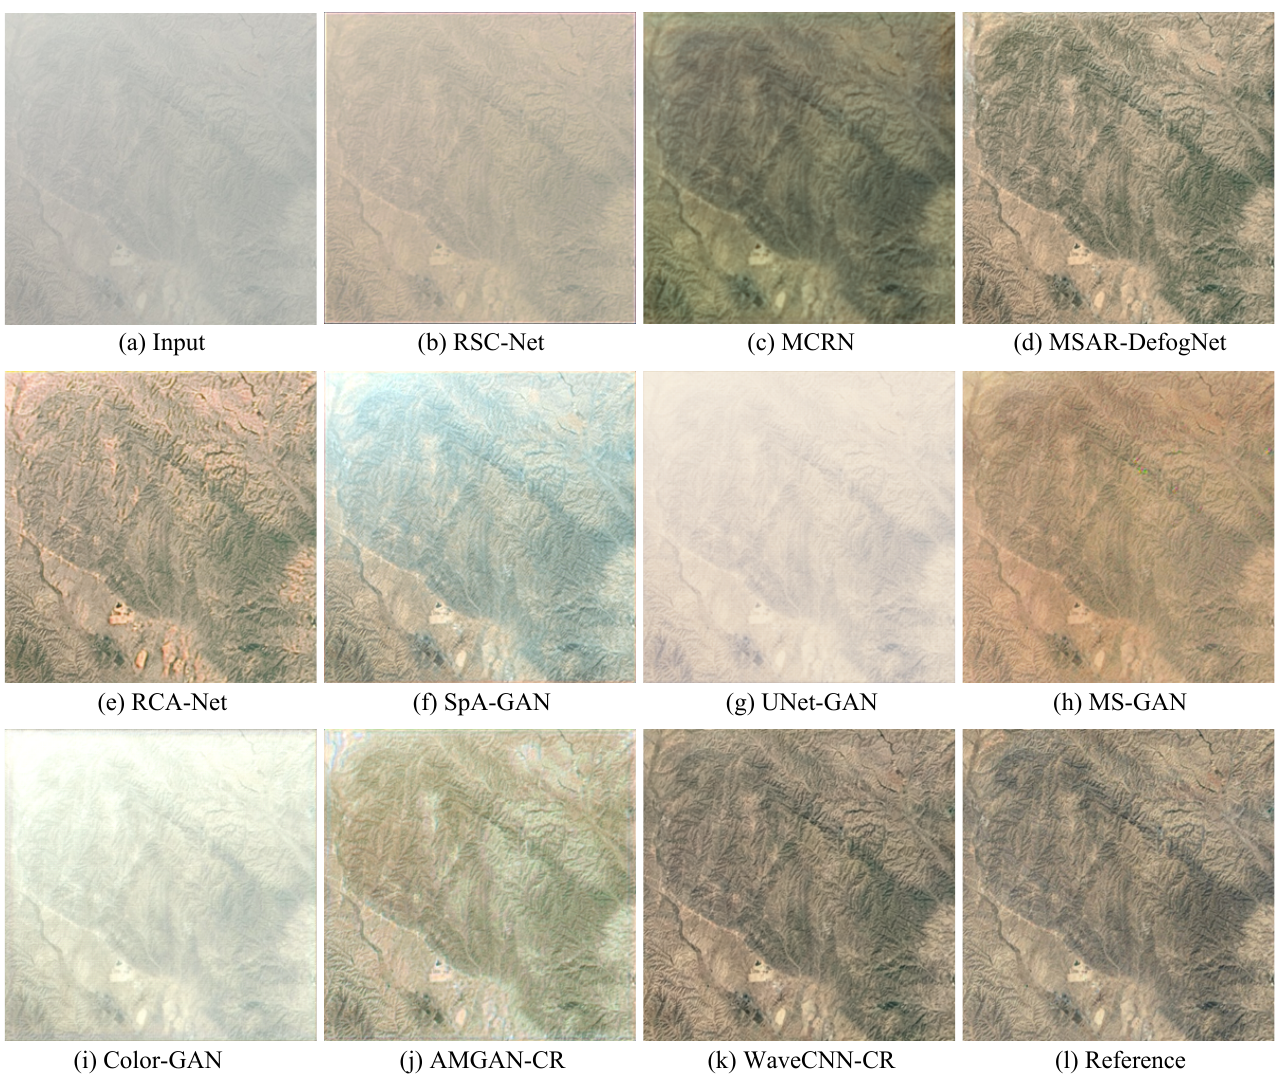
Figure 6. Visual comparisons on the RICE1 dataset: ( a ) input cloudy image; ( b – k ) results of RSC- Net [33], MCRN [50], MSAR-DefogNet [36], RCA-Net [34], SpA-GAN [45], UNet-GAN [38], MS- GAN [39], Color-GAN [44], AMGAN-CR [47], and our proposed WaveCNN-CR, respectively; ( l )